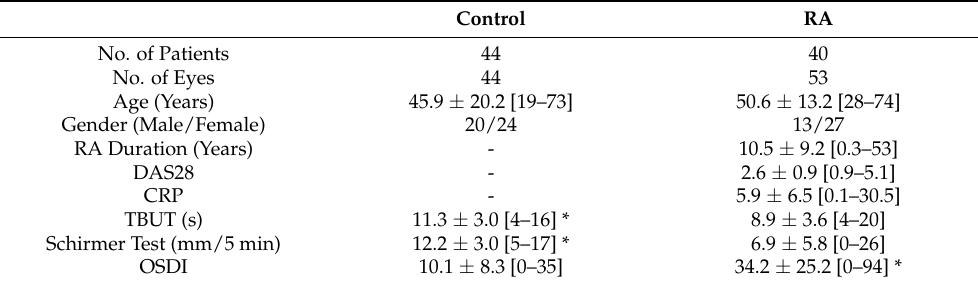
Table 1. Demographic and clinical data in the control and rheumatoid arthritis (RA) groups. Data are shown in mean, SD and min–max values; disease activity score (DAS28); C-reactive protein (CRP); tear break-up time (TBUT); and ocular-surface disease index (OSDI). * p < 0.05 Mann–Whitney test. Control RA No. of